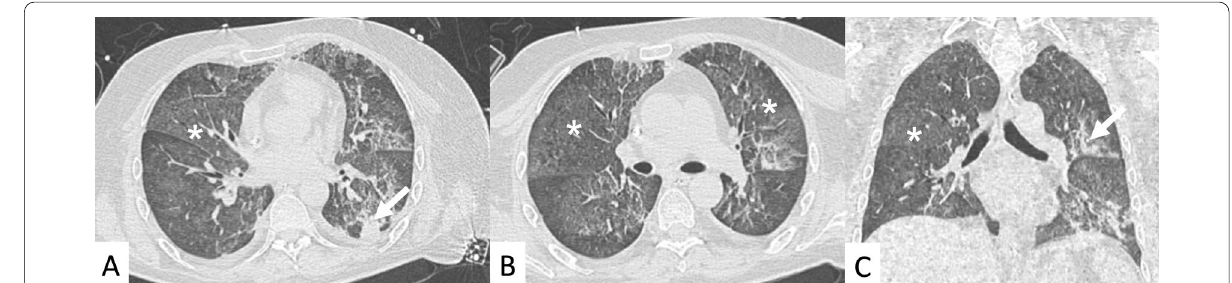
Fig. 20 A 62-year-old man with acute respiratory failure. He referred Gottron papules and acral cutaneous ulcerations one month previously; laboratory exams revealed increased Creatine-Phosphokinase levels (800 u/l) and presence of Anti-melanoma differentiation-associated gene 5 (MDA5) antibodies. Diffuse ground-glass opacifications (white asterisks in A – C ) and small consolidations (white arrows in A , C ) are depicted, suggesting HRCT features of diffuse alveolar